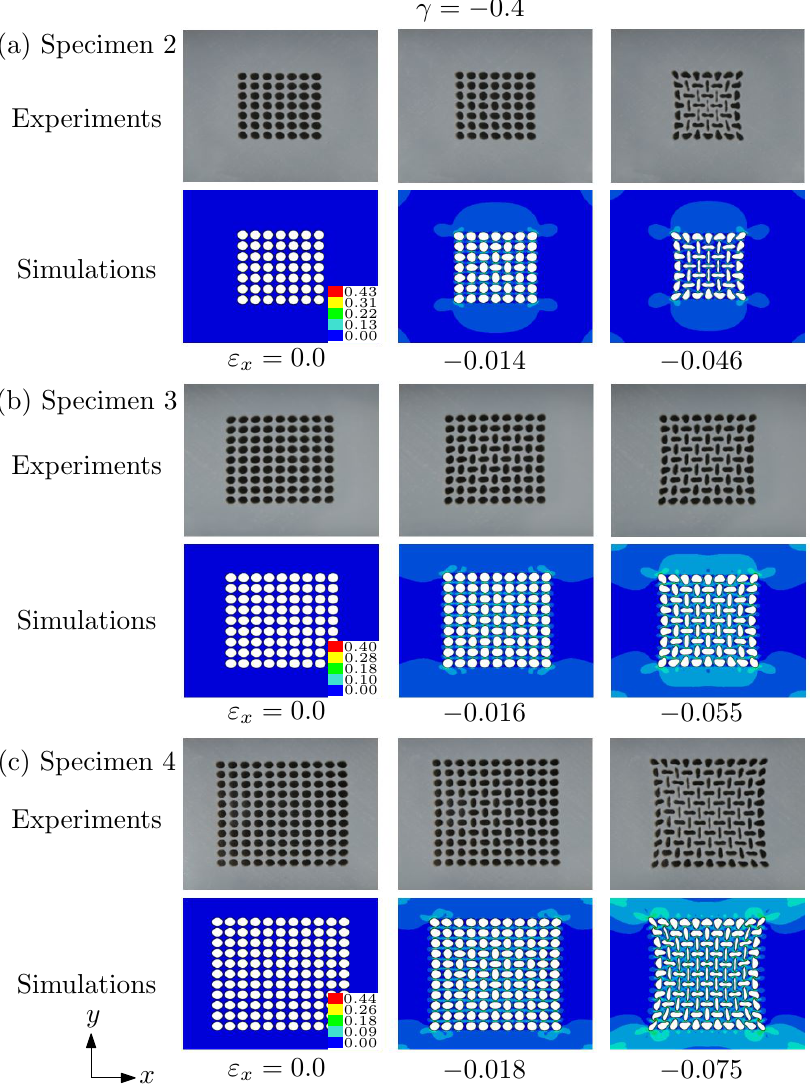
Figure 7. Deformed morphologies at different applied strains predicted by the simulations and the experiments. ( a ) Specimen 2; ( b ) specimen 3; ( c ) specimen 4. Under this biaxiality ratio γ = only PT I (alternating orthogonal elliptic voids) was discovered. The color bar shows the effective strain of the